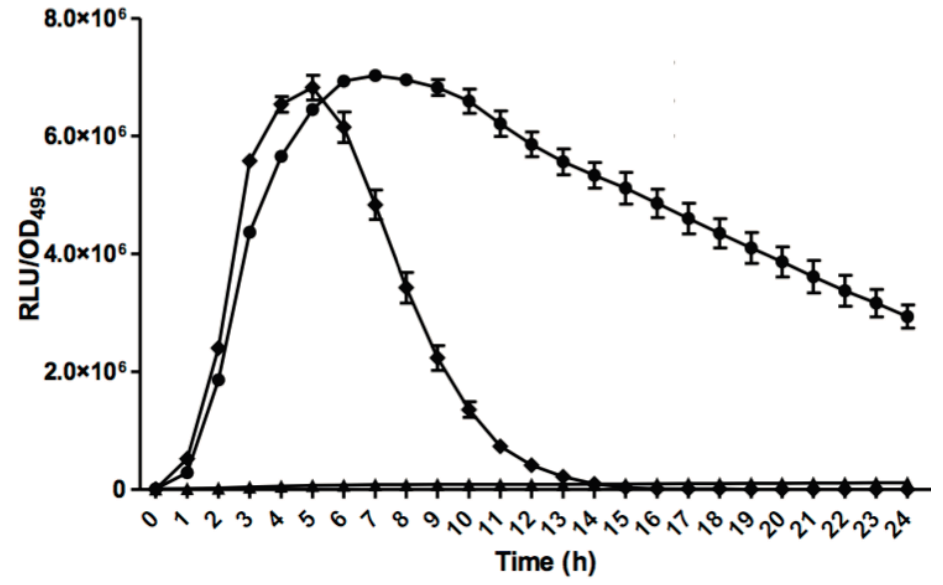
Figure 2. Measurement of bioluminescence with E. coli [pSB401] and E.coli